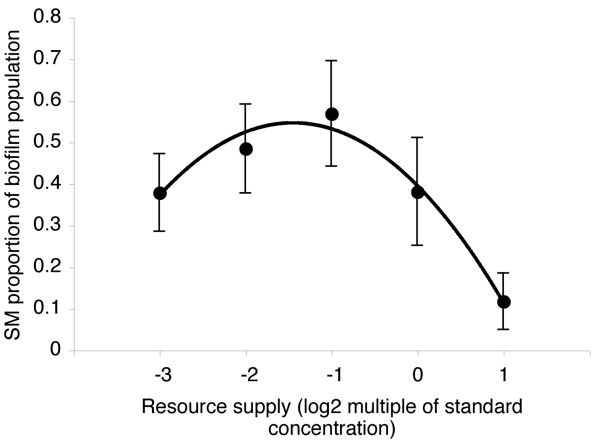
Selection for biofilm dwelling cheats peaks at intermediate resource supply. Dots represent mean ± SE proportion of biofilm dwelling population with SM colony morphology (i.e., biofilm SM density/[biofilm SM density + WS density]). These data show that selection for biofilm-dwelling SM, rather than SM per se, peaked at intermediate resource supply.